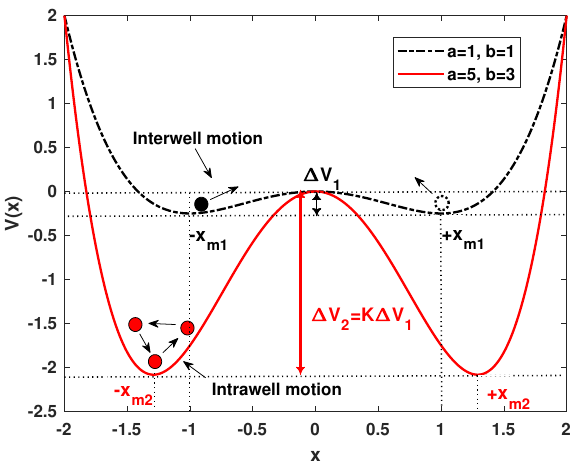
Figure 1. A demonstration of bistable stochastic resonance with interwell and intrawell